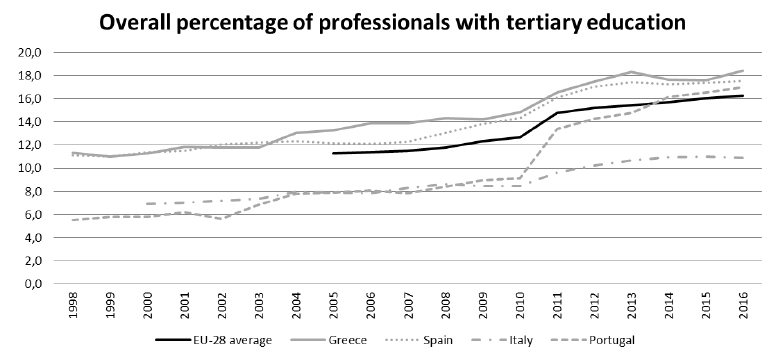
Figure 6: Overall percentage of professionals with tertiary education among employed population 1998-2016